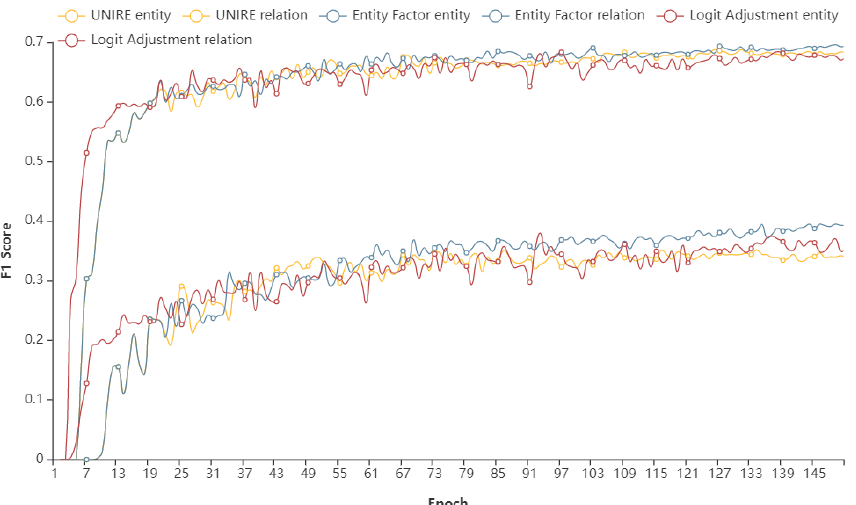
Figure 5. Training performance of models on the SciREC